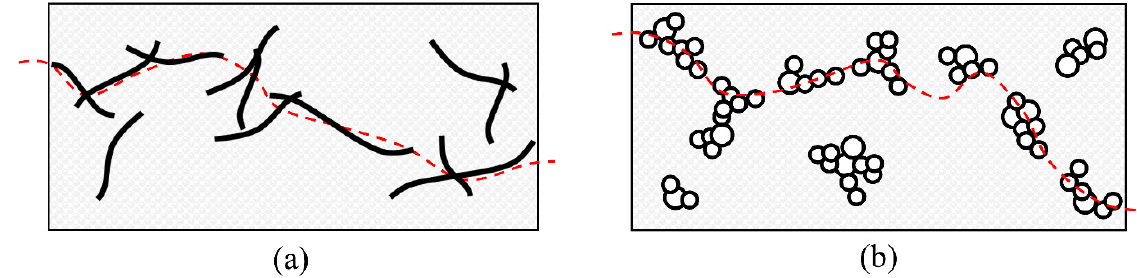
Figure 1. Structure of the percolating network in ( a ) CNT- and ( b ) CB-based systems on glass-fabric substrate. Red dashed line represents the conduction path across the continuous network.